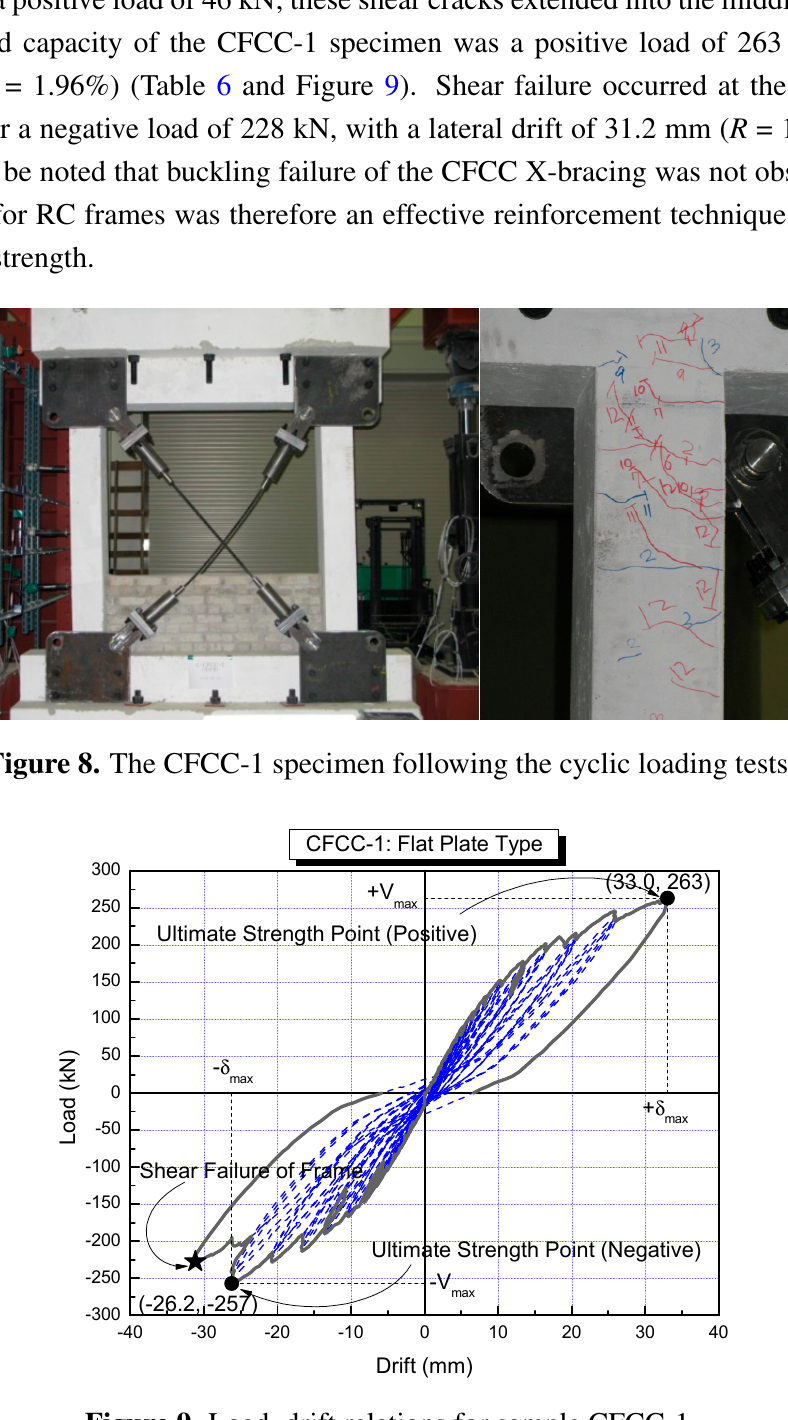
Figure 9. Load–drift relations for sample CFCC-1.